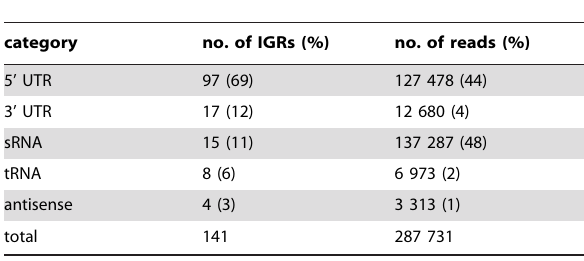
Table 7. Analysis of abundant intergenic transcripts.